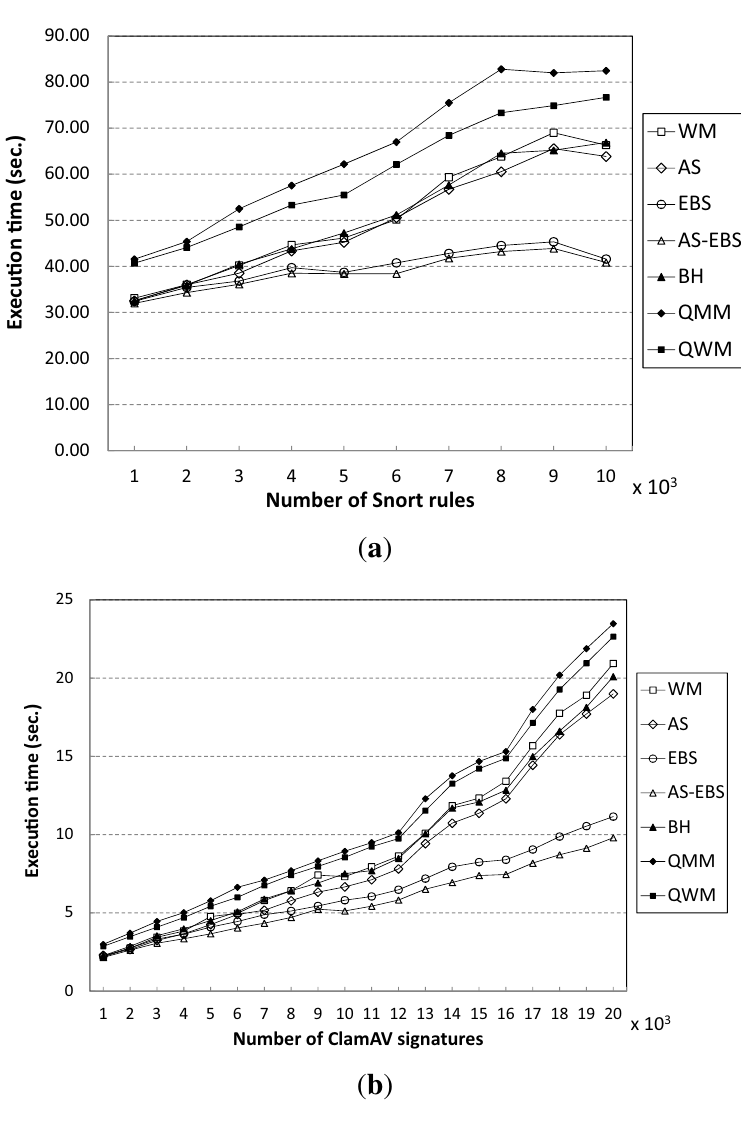
Figure 9. Performance results of various pattern-matching